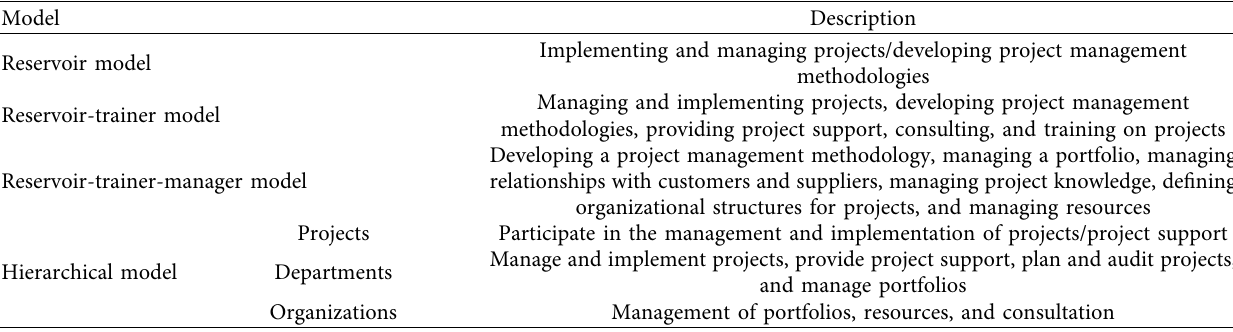
Table 1: Diference between some literature review models (Made by